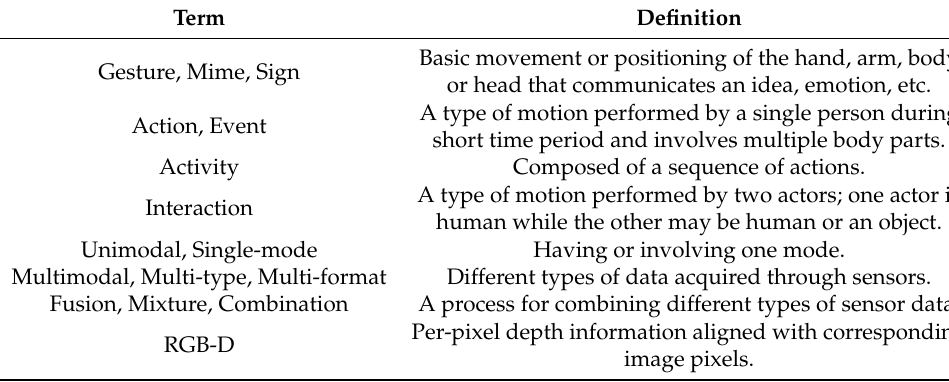
Table 1. Terms related to action